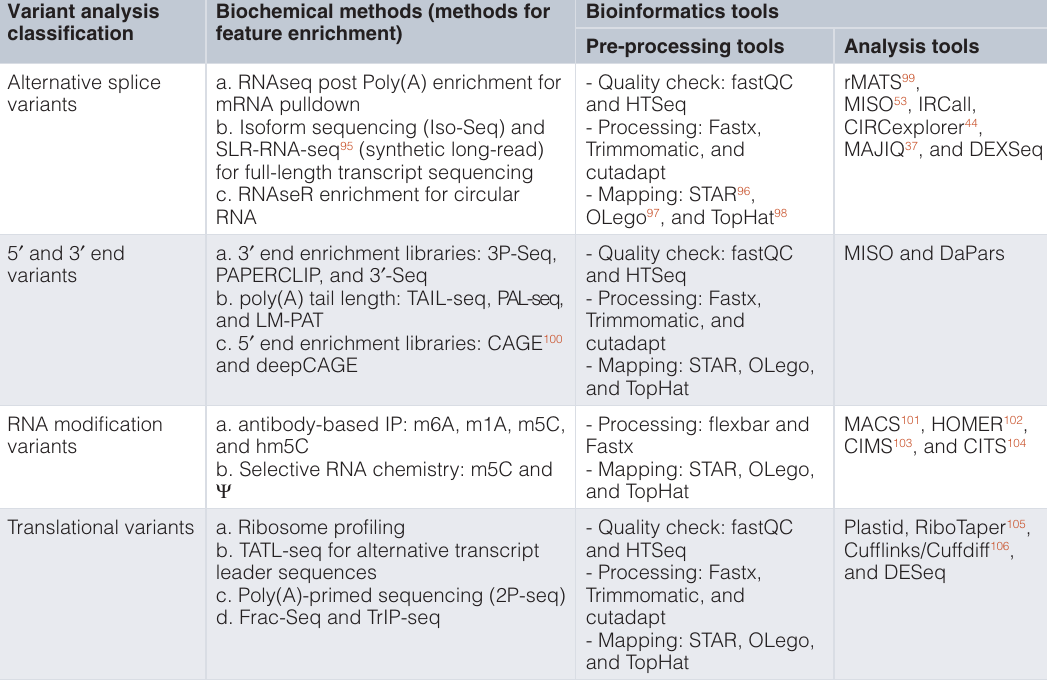
Table 1. Summary list of bioinformatics pipelines/tools for analyzing different RNA